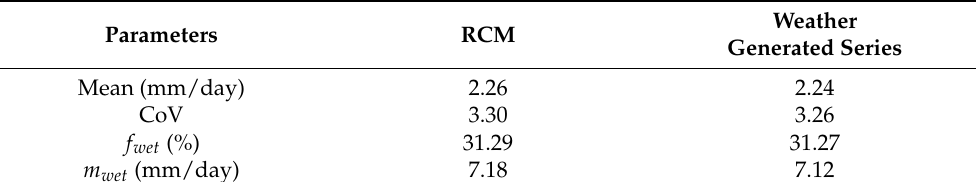
Table 1. Mean, coefficient of variation, CoV, fraction of wet days (with 0.3 mm or more), f wet , and mean wet-day amount, m wet , for the RCM ECEARTH-HIRHAM5 and the generated series at cell 101 for the period 1981–1990.